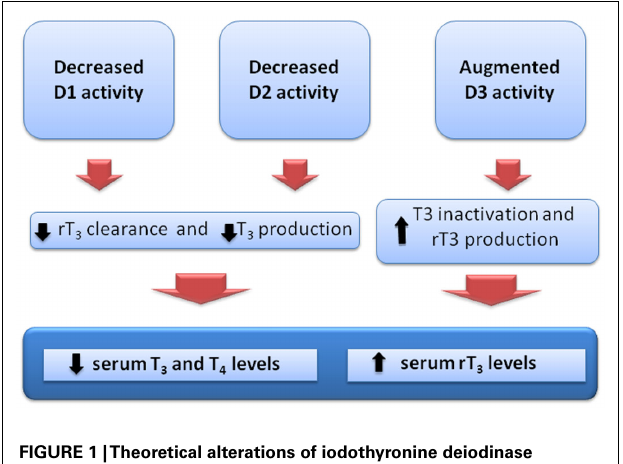
FIGURE 1 |Theoretical alterations of iodothyronine deiodinase activities and consequent changes in the serum thyroid hormone levels, as observed in the non-thyroidal illness